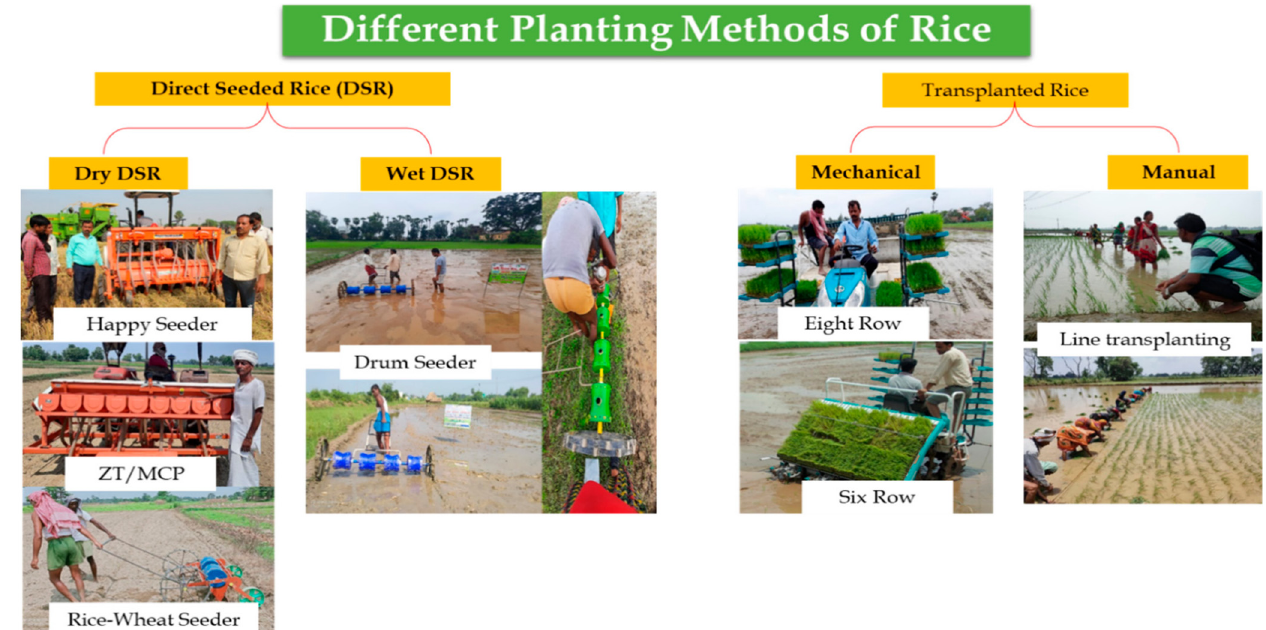
Figure 2. Different crop establishment methods of rice.